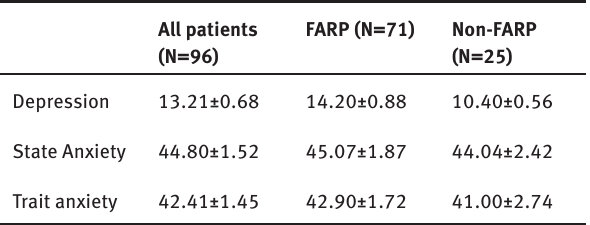
Table 5: Depression and anxiety scores for FARP and non-FARP patients